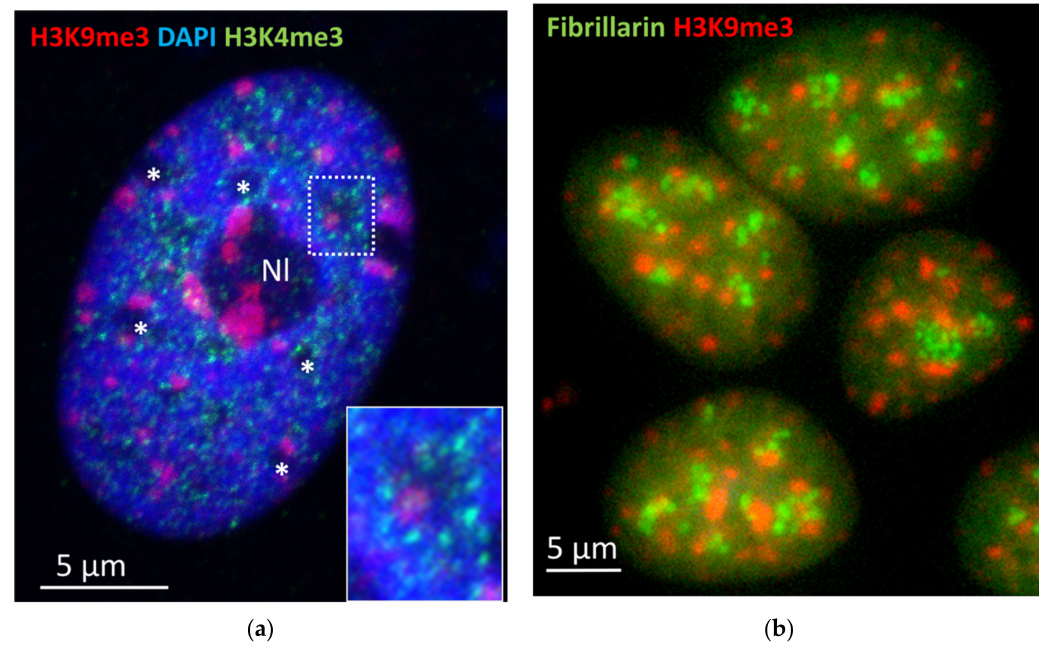
Figure 9. The topological relationship between PADs, NADs, and transcription hubs in MCF7 cells: ( a ) H3K9me3-labelled PADs are located near or inside the DAPI-poor alveoli decorated by H3K4me3-positive foci (enlarged on insert) which are ( b ) often occupied with the fibrillarin-marked